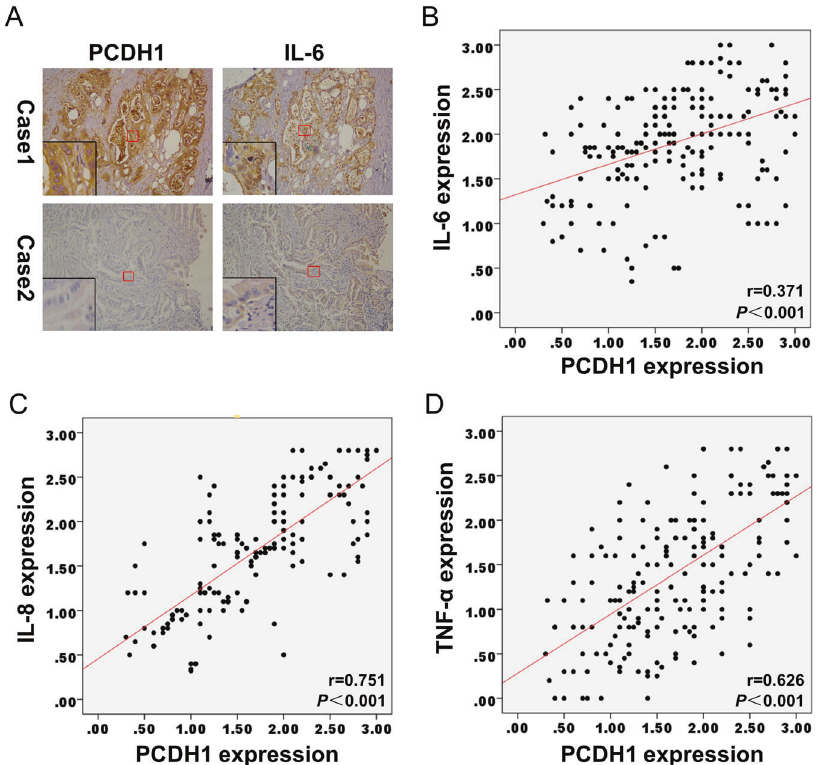
Fig. 5 Correlation between the expression of PCDH1 and NF- κ B downstream effectors in 197 PDAC tissues. A Representative IHC staining for PCDH1 and IL-6 is shown in two PCAC tissues. Correlations were detected between IL-6 ( B ), IL-8 ( C ), TNF- α ( D ) and PCDH1 expression by Pearson ’ s test in 197 PDAC